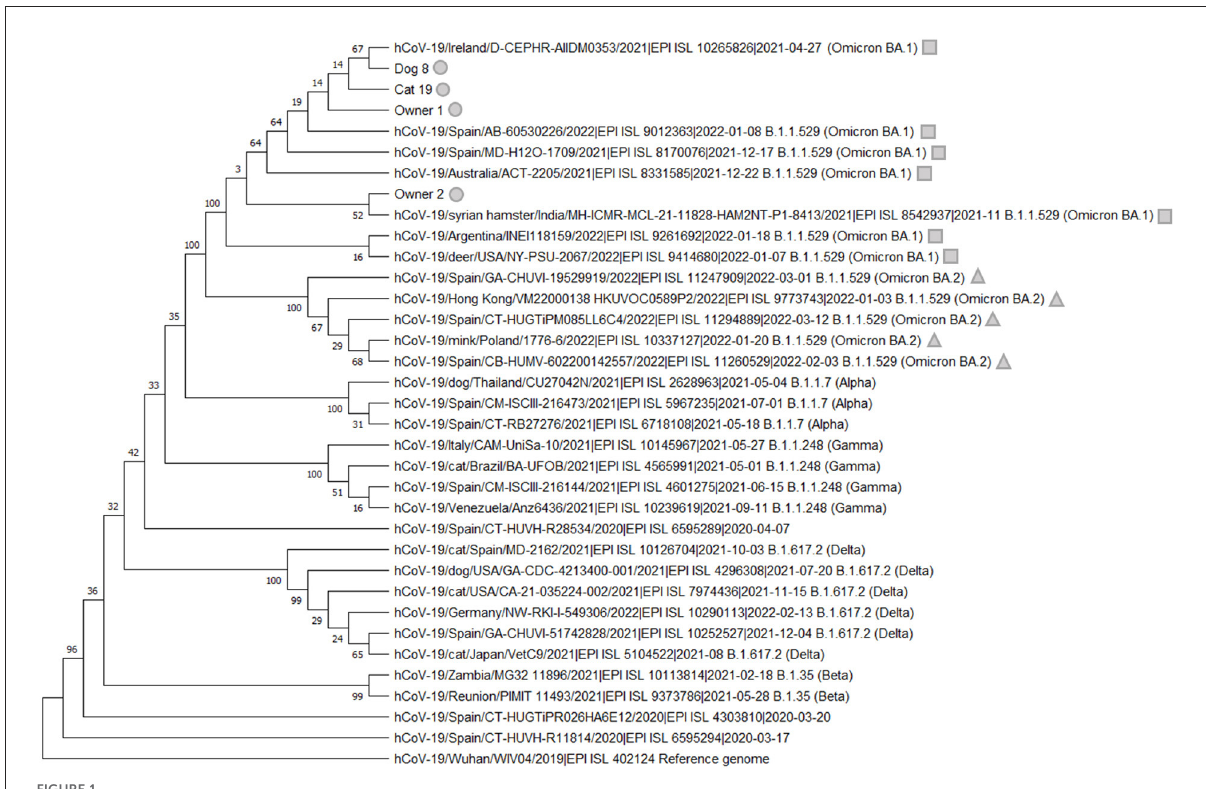
FIGURE1 Phylogenetic analysis of SARS-CoV-2 of the whole-genome sequences from Dog_8, Cat_19, Owner_1, and Owner_2 (gray circle), which were clustered with the SARS-CoV-2 B.1.1.529 (Omicron) and more specifically with lineage BA.1 (gray square). The lineage BA.2 is indicated with a gray triangle. We appreciatively acknowledge the different laboratories and funders of GISAID for offering these SARS-CoV-2 sequences (Supplementary material